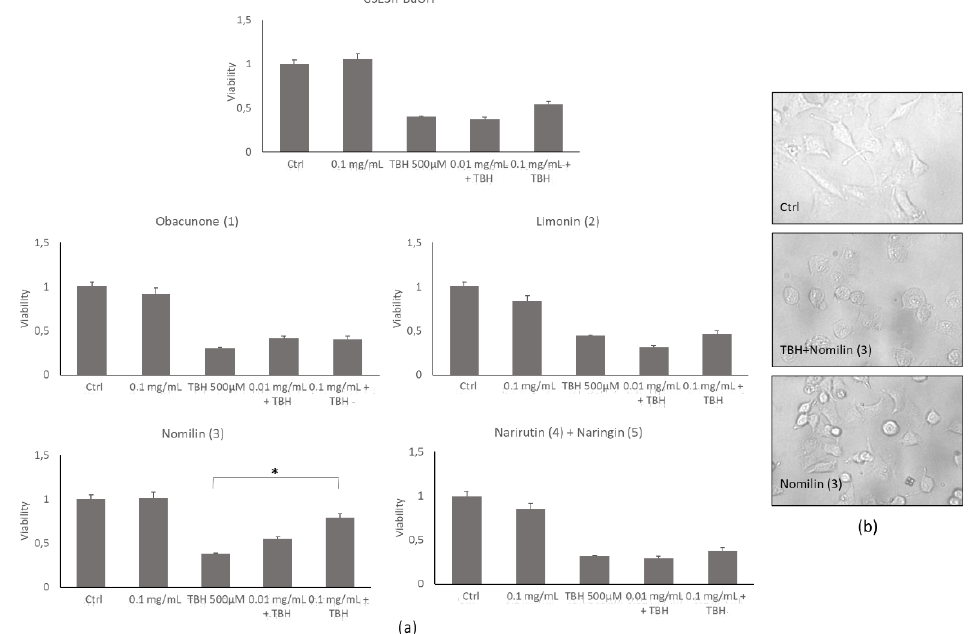
Figure 6. A549 cell viability and cell morphology of grapefruit seeds’ butanol extract ( GSE3 n-BuOH ) and isolated pure compounds (obacunone ( 1 ), limonin ( 2 ), nomilin ( 3 ), narirutin ( 4 ) + naringin ( 5 )). ( a ) Histograms of viability assay on untreated cells (Ctrl) or cells treated with TBH alone or with grapefruit seed extracts at increasing concentrations for 2 h. ( b ) Representative morphological images of untreated cells (Ctrl) or cells treated with TBH or cotreated with TBH and nomilin ( 3 ) at 0.1 mg/mL. * p < 0.05 compared to treated (TBH) group.